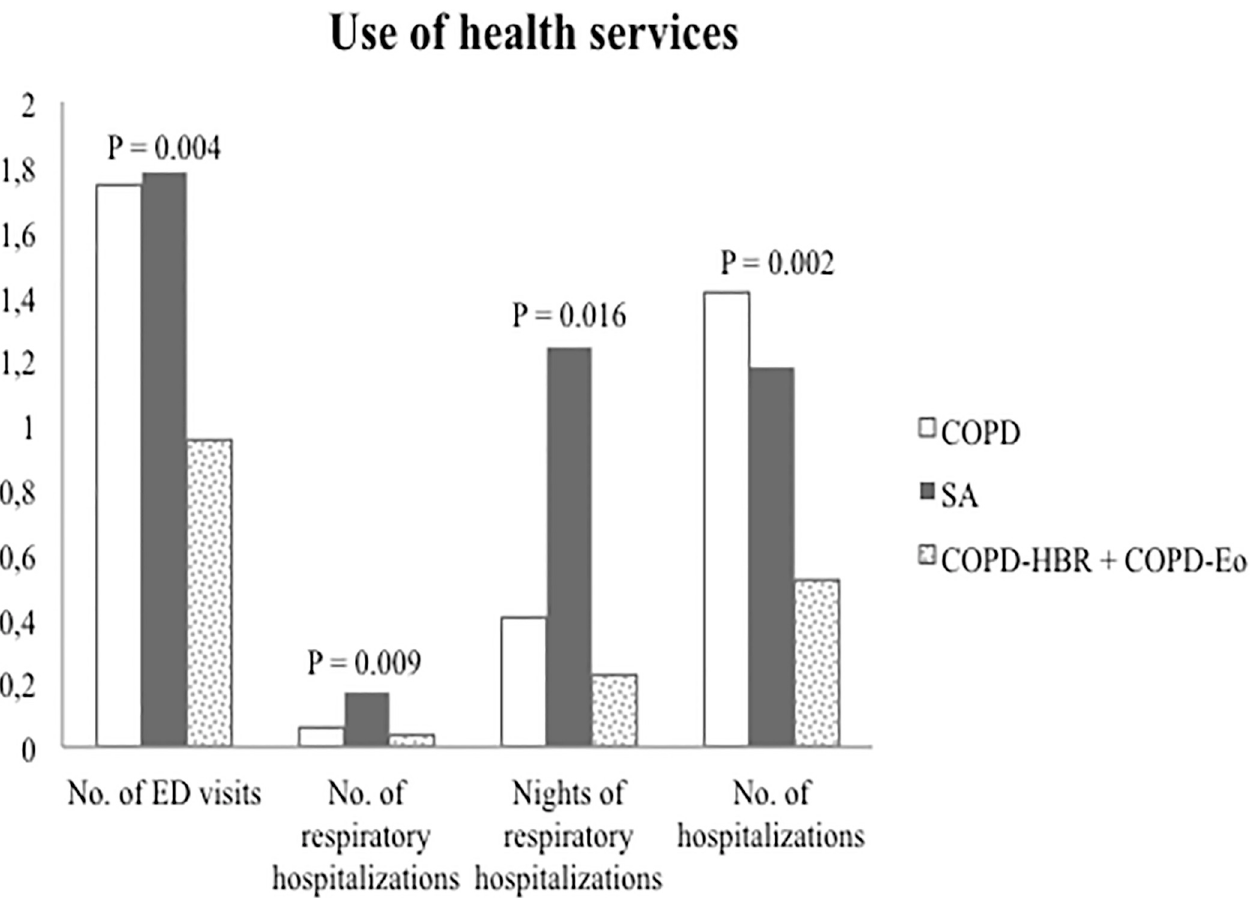
Fig 4. Use of health resources. COPD: Chronic obstructive pulmonary disease; ACO: Asthma-COPD overlap; No: number; ED: emergency department.